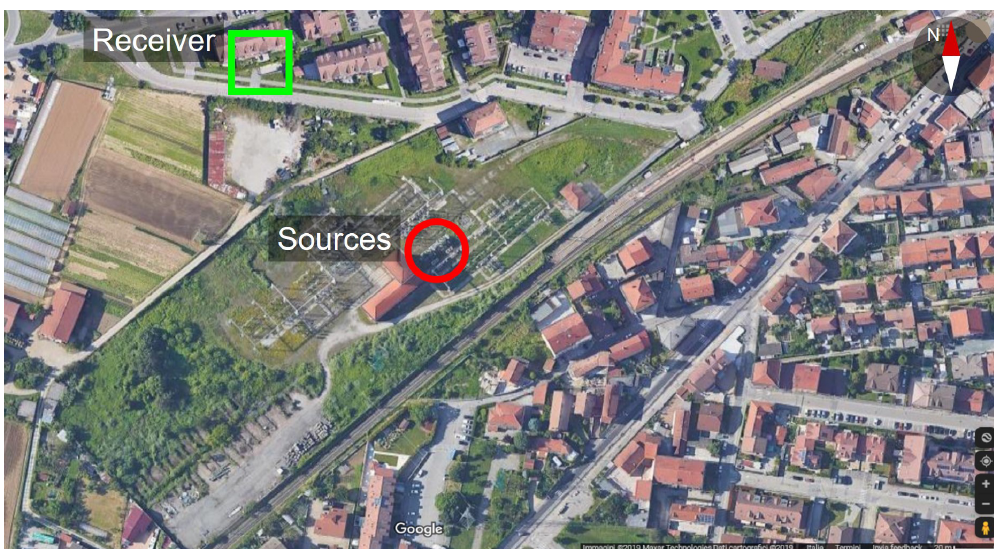
Figure 1. Satellite image of RPS substation. Sources circled in red; receiver in green box. Imagery c (cid:13) 2019 Maxar Technologies, Map data c (cid:13) 2019 Google.